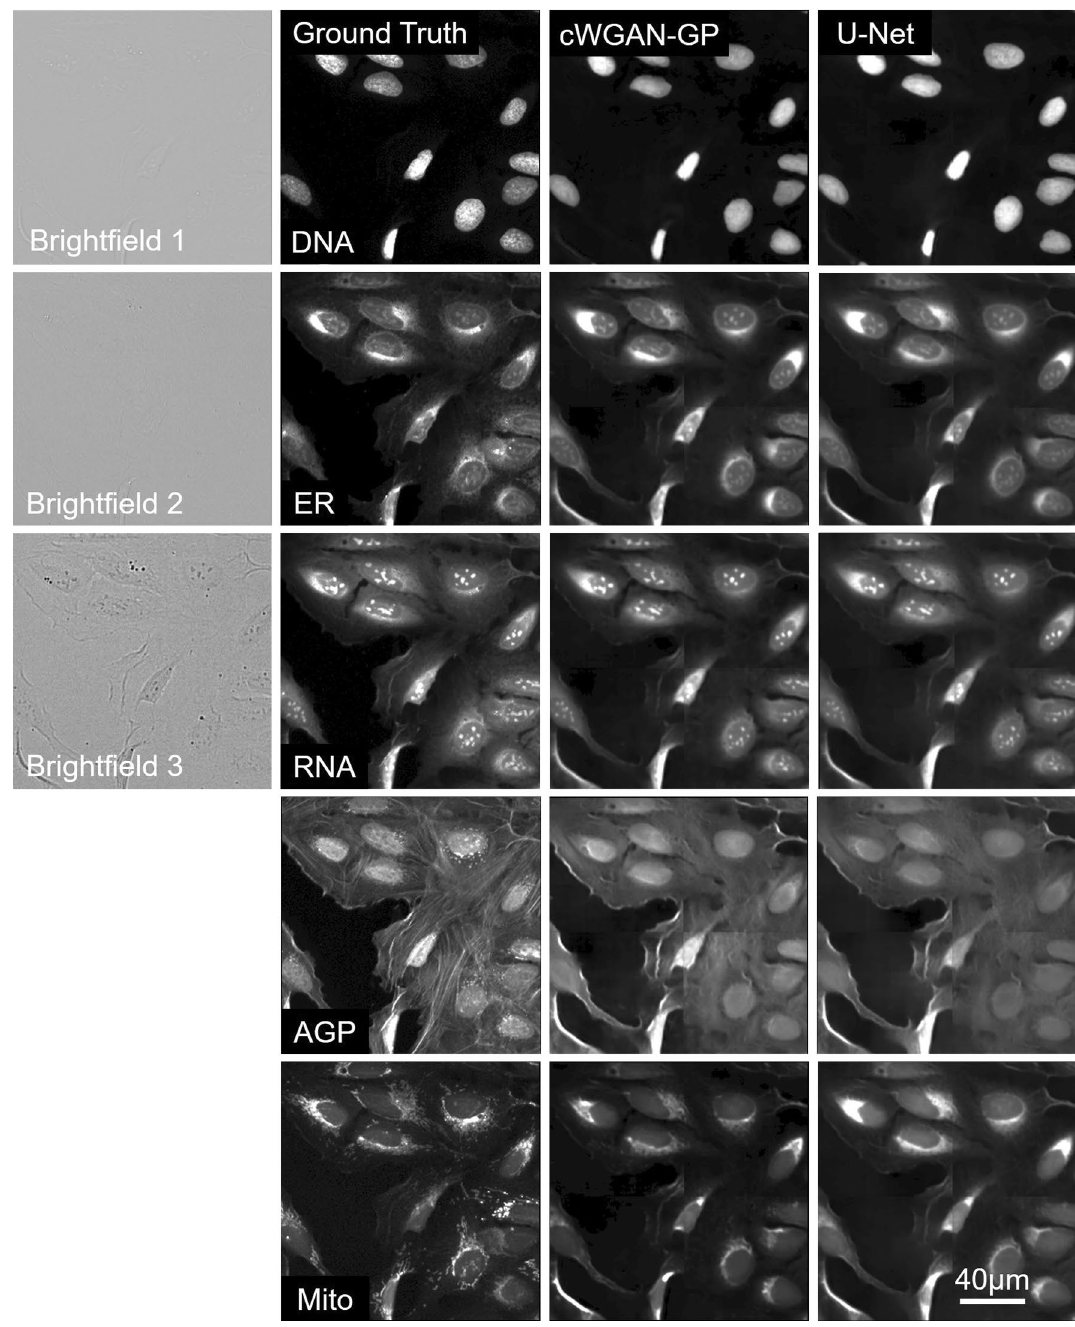
Figure 2. Cropped images of typical brightfield images, ground truth fluorescent, and predicted channels from the test dataset (Table 1) for the U-Net and cWGAN-GP models. Presented at scale of the input and output size used in the model networks (256 × 256 pixels), the first column contains the three brightfield z-planes which form the input, and the subsequent columns are the five fluorescent output channels. The stitching method has been applied to the model predicted images, and small artefacts of this process are visible. Images are independently contrasted for ingly, only the plasma membrane of AGP channel was successfully predicted, whereas the models were not able to reproduce the actin filaments and the Golgi-apparatus structures. Similarly with the Mito channel, the models performed well overall in predicting the mitochondrial structures, but we observed lack in small granularity and detail that was present in the ground truth. In addition, we observed that the blocking effect from inference time sliding window was visible in the generated images. Nevertheless, DNA, ER, and RNA channels were better predicted, of which RNA achieved the best image-level performance.